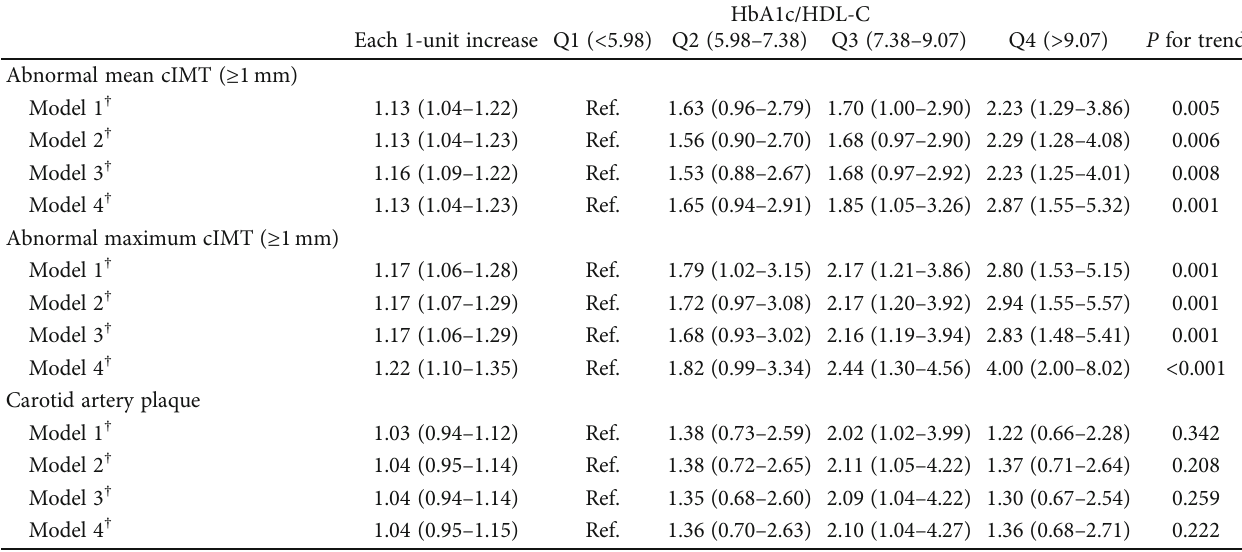
Table 3: OR (95% CIs) of abnormal cIMT and carotid artery plaque by quartiles of the HbA1c/HDL-C ratio in patients with DM ( n = 450 ).